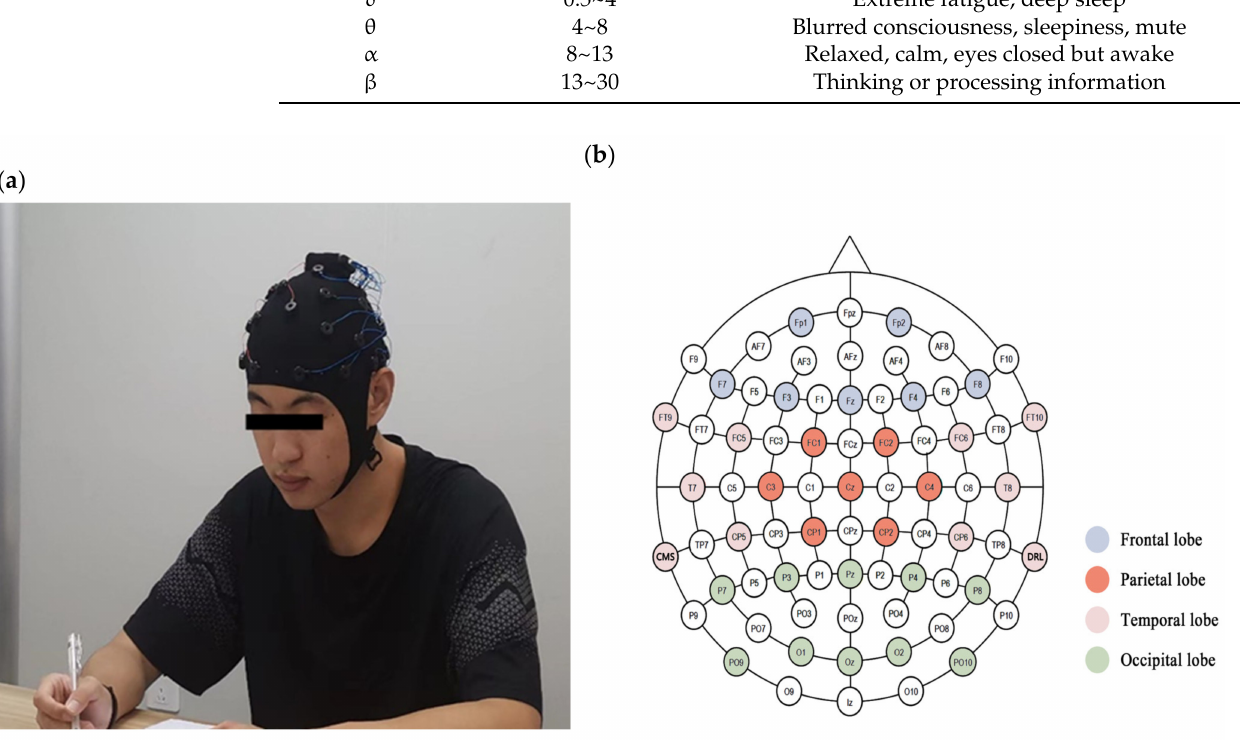
Figure 6. Emotiv EPOC Flex ( a ) setup and ( b ) EEG electrode